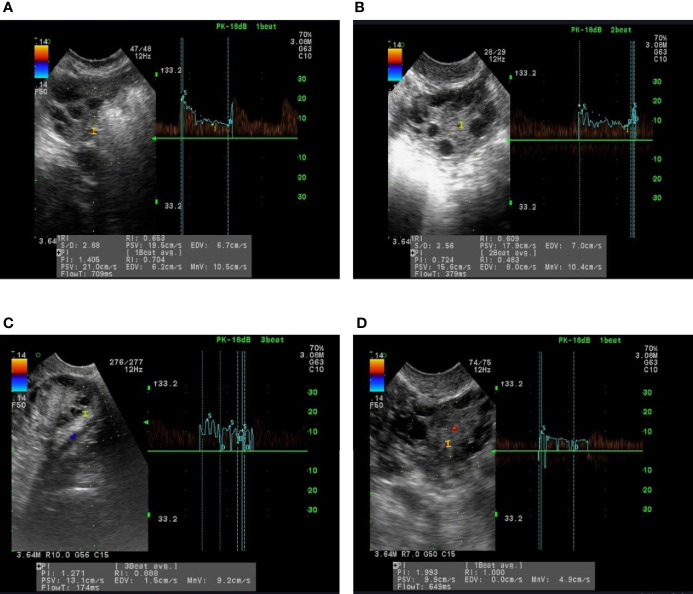
Images of ultrasound recordings of ovarian blood flow among PCOS patients after Diane-35 treatment. Images (A–D) are of representative patients in groups (A–D), as described in the methods section.